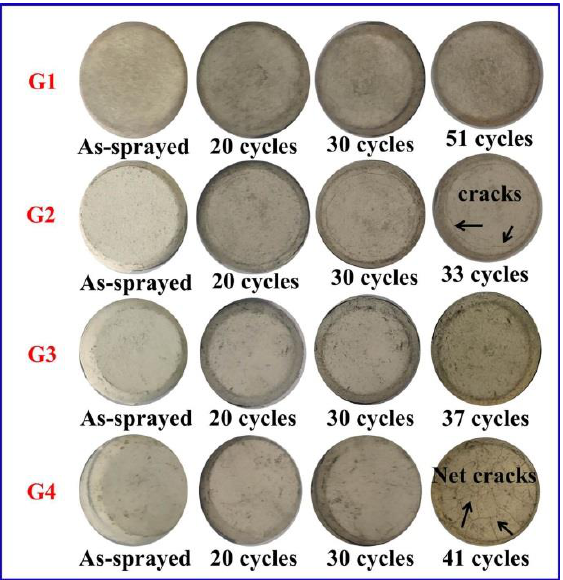
Figure 8. Surface morphologies evolution of samples during thermal cycling test.